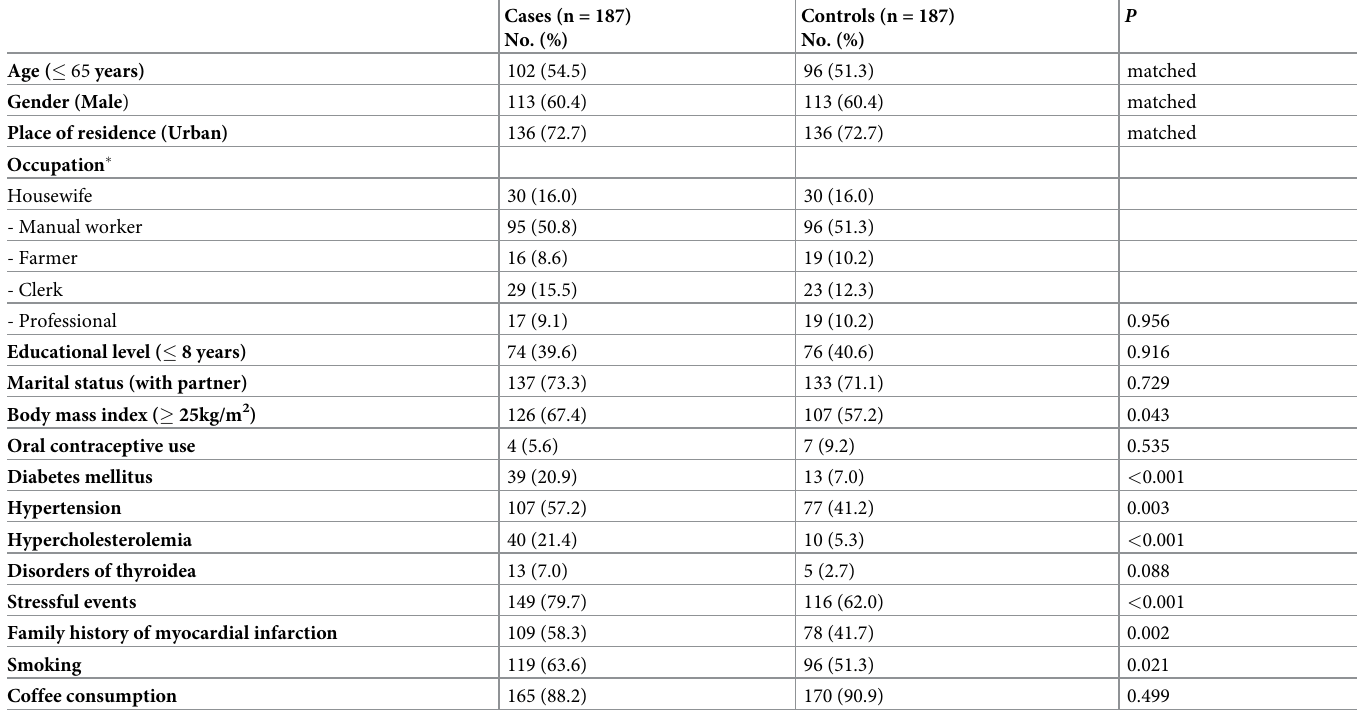
Table 1. Characteristics of patients with acute myocardial infarction and their